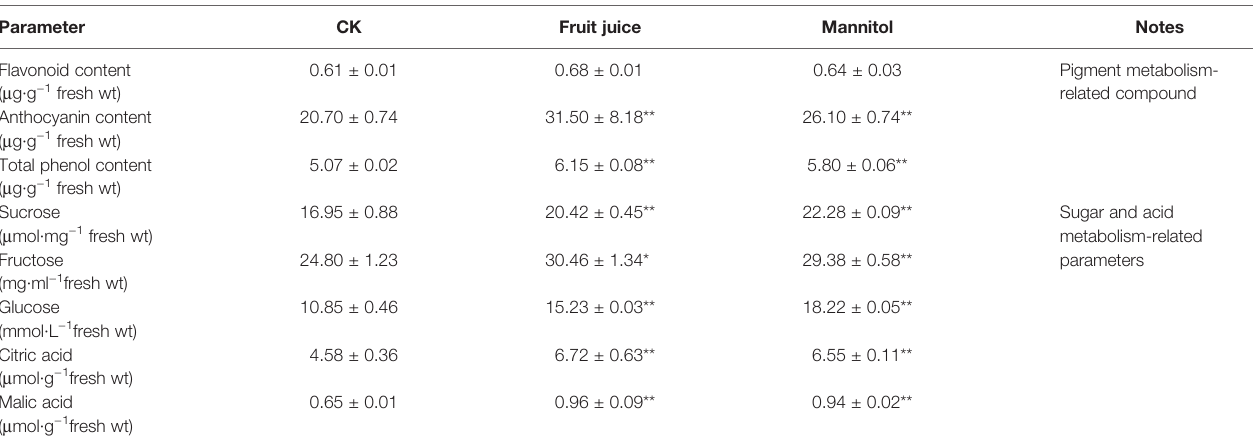
TABLE 2 | Effects of mannitol and fruit juice treatment on major fruit ripening-related